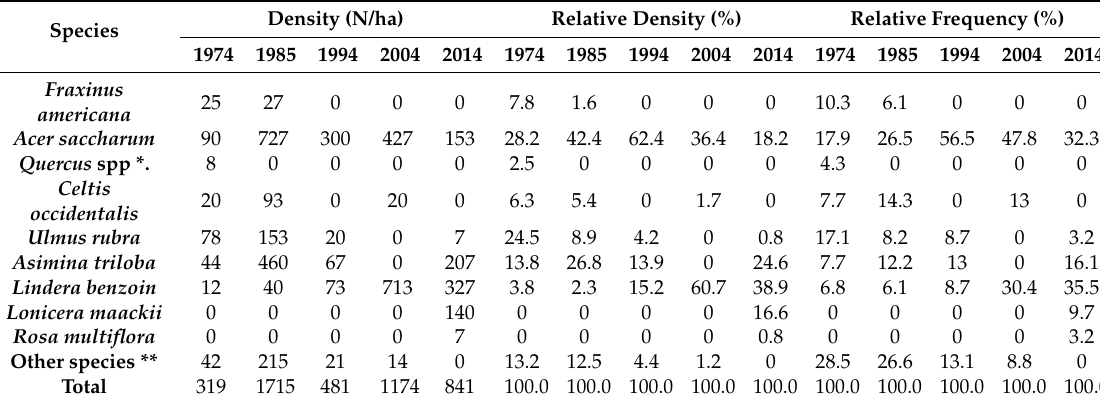
Figure 10. Shannon diversity index values of all saplings (Height ≥ 1.4 m; DBH ≤ 9.9 cm) and seedlings (Height < 1.4 m) for all woody species recorded at Dinsmore Woods across the five sampling periods. Table 5. Density (N/ha), Relative Density, and Relative Frequency for the dominant woody species recorded in the sapling class (Height > 1.4 m; DBH ≤ 9.9 cm) at Dinsmore Woods across the five sampling